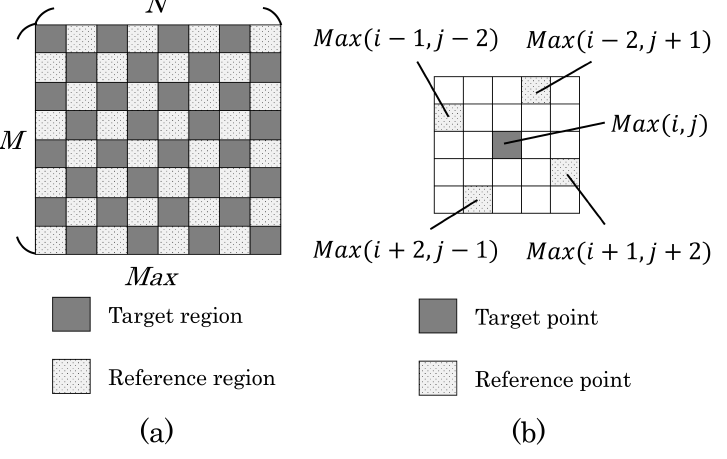
Figure 3. Sharpening and smoothing using Max . ( a ) Region segmentation. ( b ) Target and reference